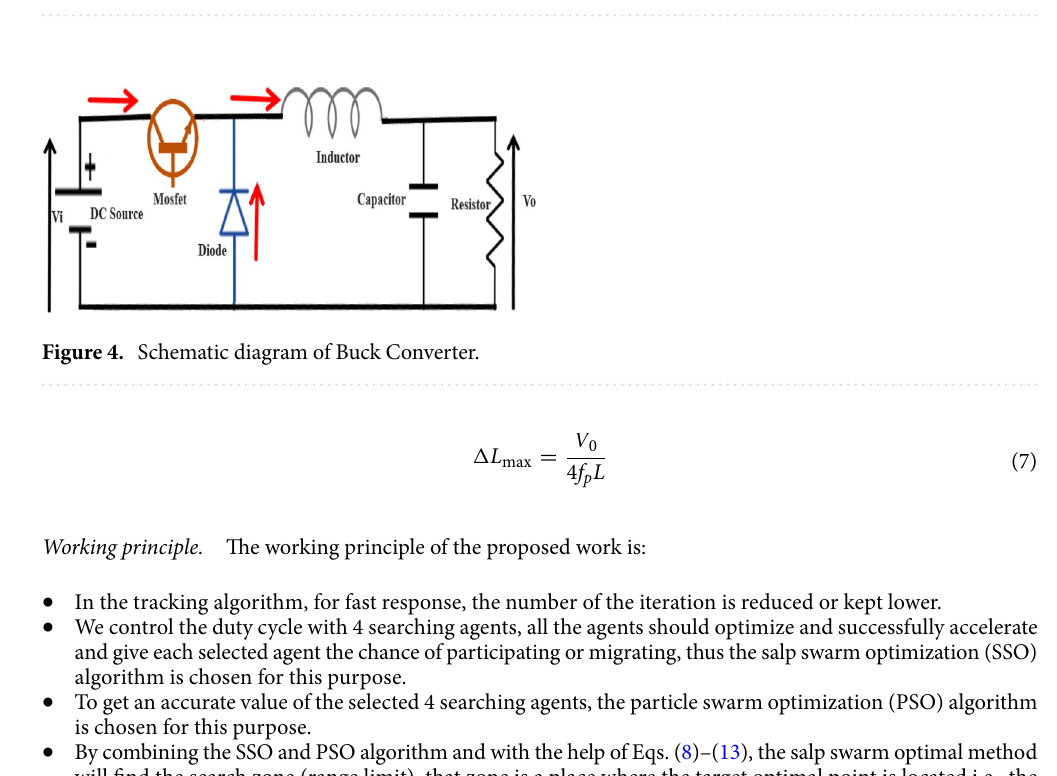
Figure 3. Depicted the I-V, P-V curves with varying irradiance and temperature.